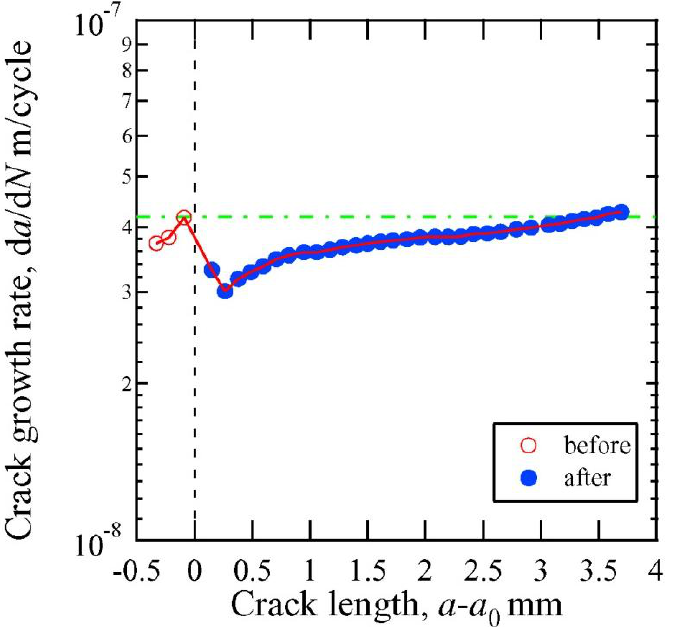
Figure 10. Fatigue crack growth rate as a function of crack length before the application and after the 20th application of electropulsing for Sample